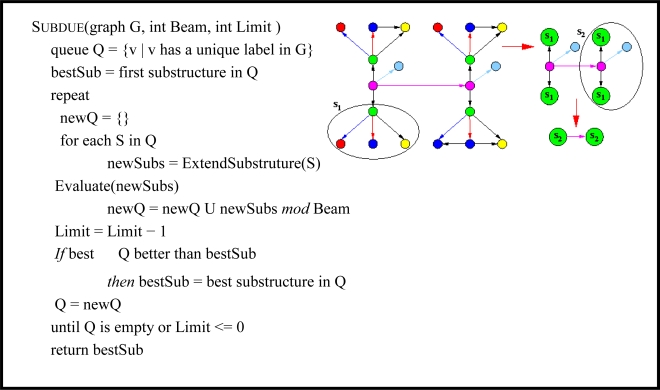
Subdue’s discovery algorithm and an example. The figure shows the discovered pattern (S1) from the original graph, the substructure found during the second iteration (S2), and the final graph compressed using substructures S1 and S2.